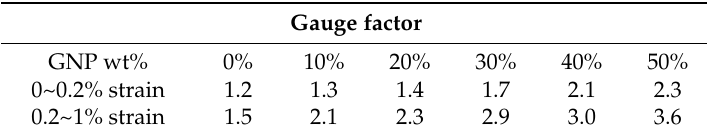
Table 3. Gauge factor for different strain